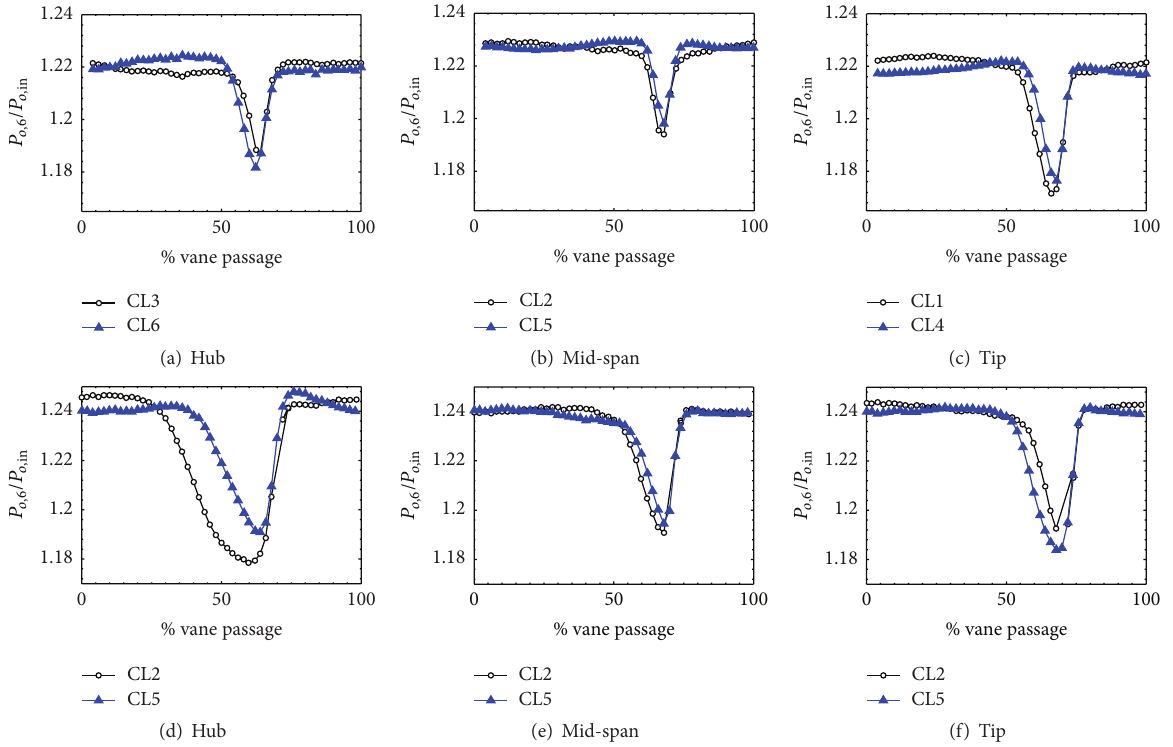
Figure 8: Stator 2 wakes near the peak efficiency loading (30%SM) for (a) hub, (b) mid-span, and (c) tip region, and at a high loading condition (14%SM) for the (d) hub, (e) mid-span, and (f) tip.